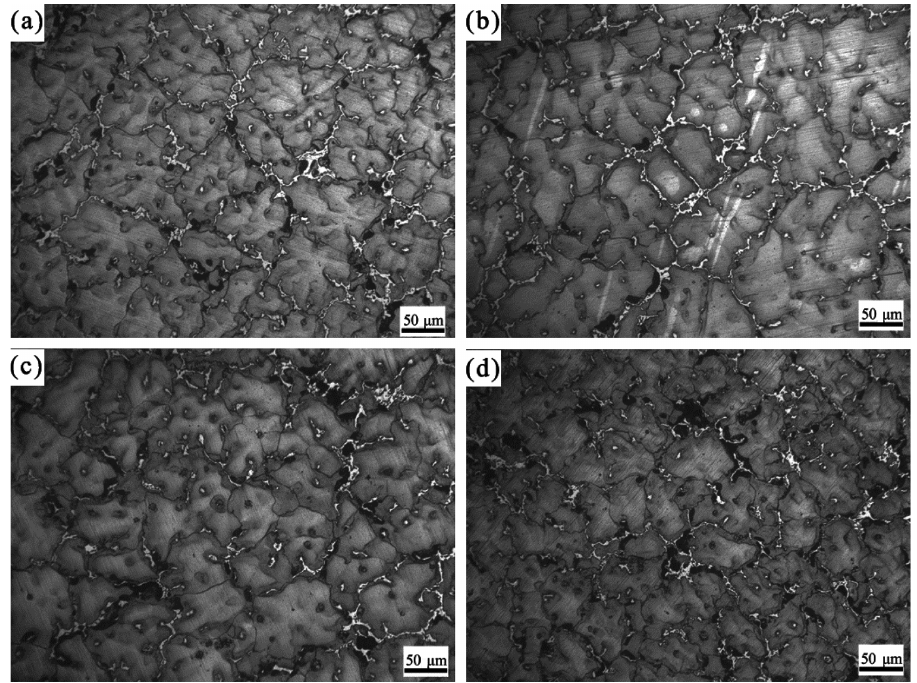
Figure 2: Optical micrographs of the as-cast AZ80 – 2Sn alloys with different Bi additions: (a) 0 mass %Bi; (b) 0.5 mass %Bi; (c) 1 mass %Bi; (d) 1.5 mass